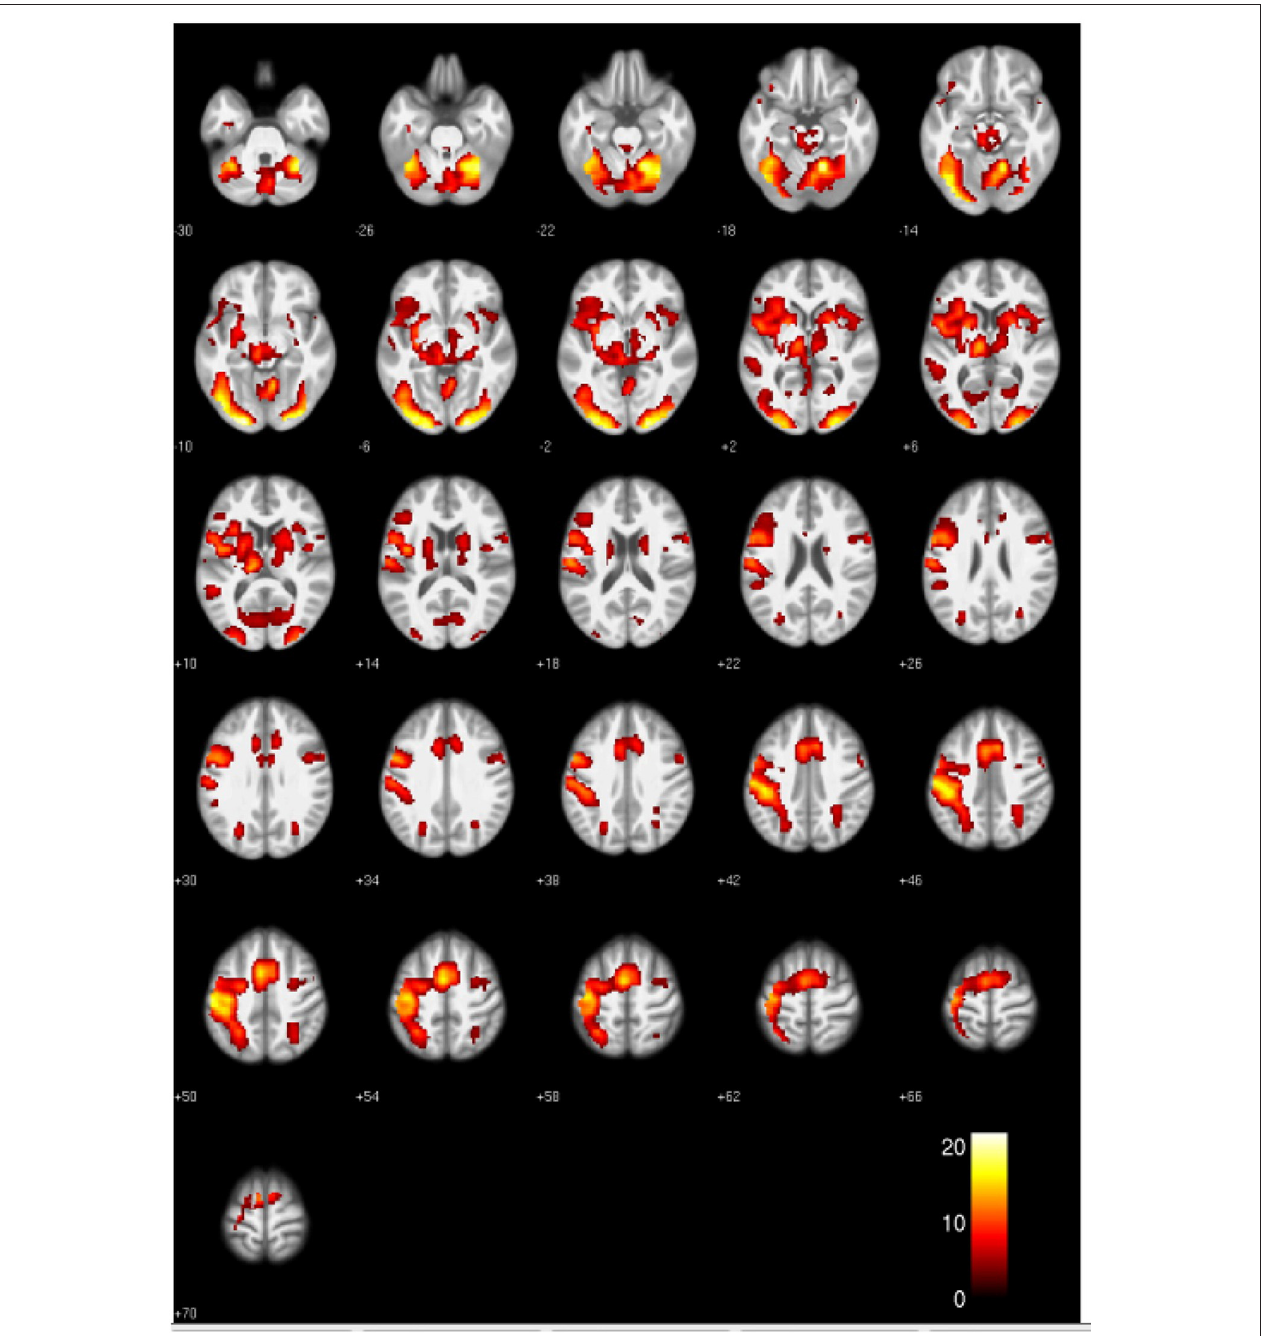
FIGURE 1 | Activation clusters revealed by the whole brain analyses. Regions that elicited increased activation for words compared to baseline (irrespective of group) are shown in yellow. All clusters were extracted at a threshold of p < 0.001 [uncorrected, with a FWE cluster-level-correction ( p <